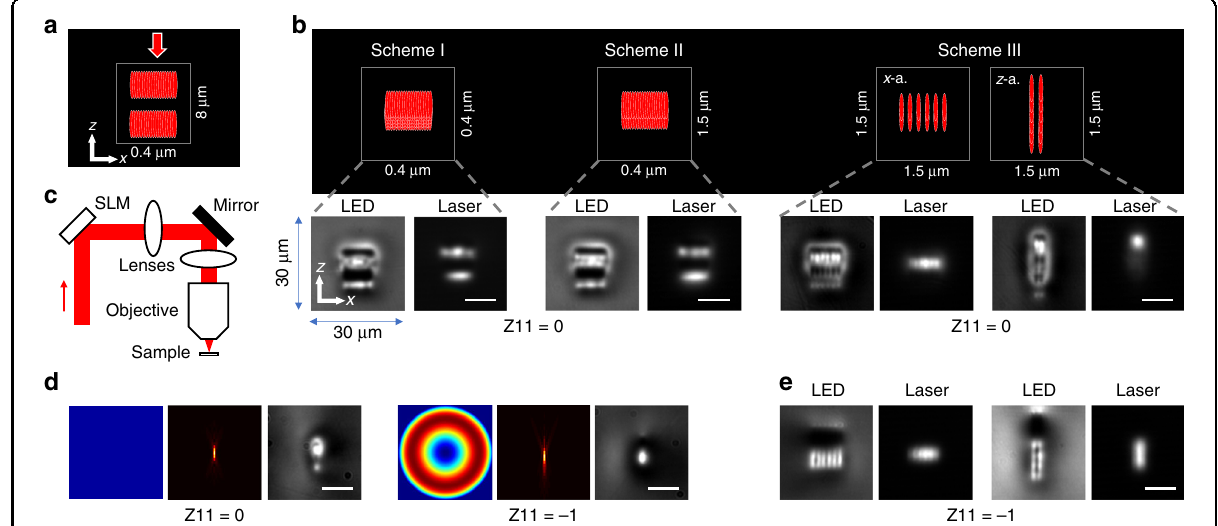
Fig. 1 Enabling fi ne control of waveguide cross-section shape and sizes by SPIM-WGs. All images (LED, laser, simulation) excluding the phase pattern have the same frame size of 30 × 30 µm. Scale bars are 10 µm. a Classic multiscan laser fabrication technique has a large z step resolution (8 µm in this case). The red arrow marks laser propagation direction. Distances of core spacing along x axis ( Δ x ), and z axis ( Δ z ) are presented beside the diagram. b Three proposed fabrication schemes and the corresponding fabricated waveguides. In experimental demonstrations, Scheme I had Δ x = Δ z = 0.4 µm, with 20 horizontal and 6 vertical scans. Scheme II had Δ x = 0.4 µm, Δ z = 1.5 µm, with 20 horizontal and 2 vertical scans. Scheme III had Δ x = Δ z = 1.5 µm, with six horizontal and two vertical scans for the x- aligned rectangular waveguide, two horizontal and six vertical scans for the z- aligned rectangular waveguide. Labels: “ LED ”— images obtained with LED-illuminated microscope; “ Laser ”— 785 nm laser transmission mode pro fi le imaged at the waveguide output facet; “ Z11 ”— manually induced primary spherical aberration 61 (corresponding to Zernike mode 11